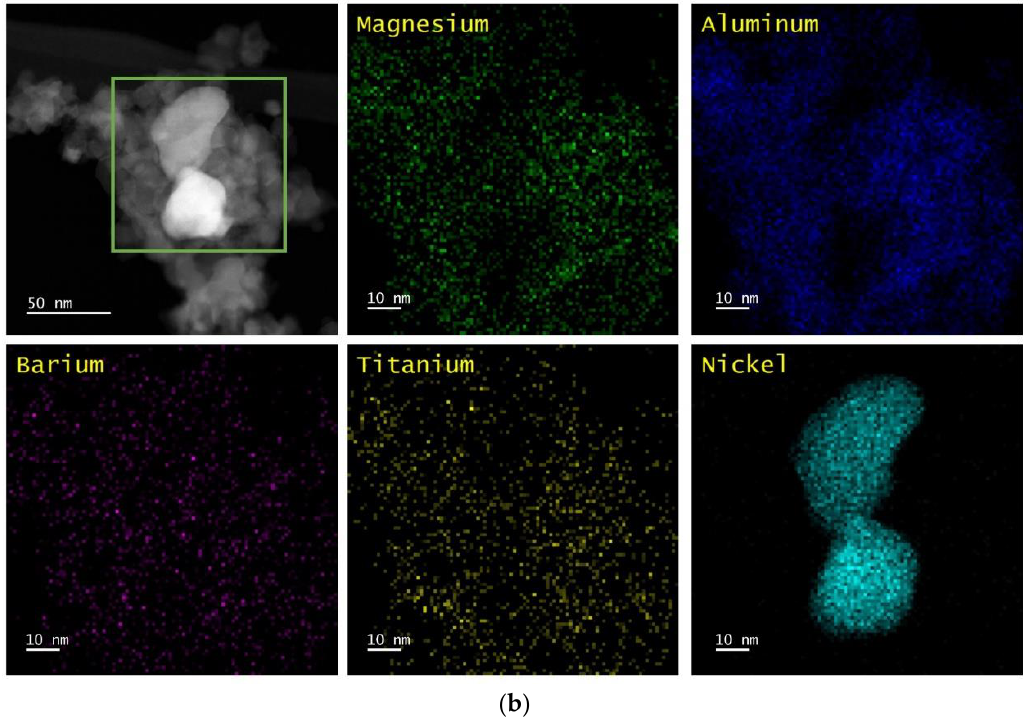
Figure 3. ( a ) Representative STEM results for Ni / BaTiO 3 / MgAl 2 O 4 after 1073 K oxidation followed by 773 K reduction with EDS maps of corresponding elements. ( b ) Representative STEM results for Ni / BaTiO 3 / MgAl 2 O 4 after 1073 K oxidation, followed by 1073 K reduction with EDS maps of corresponding elements.